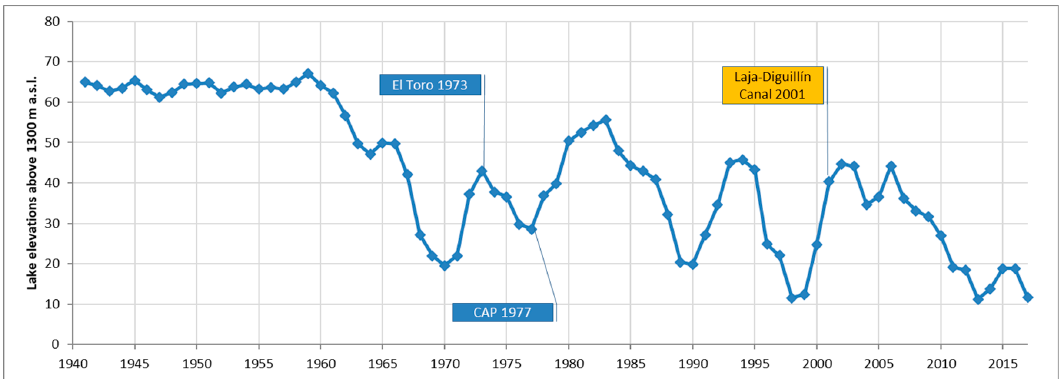
Figure 2. Laja Lake mean annual elevation above a reference of 1300 m.a.s.l. Blue text boxes indicate when anthropogenic changes were made to the lake basin (as explained in the text), and the orange text box indicates when a new demand for lake water (for irrigation) was added.